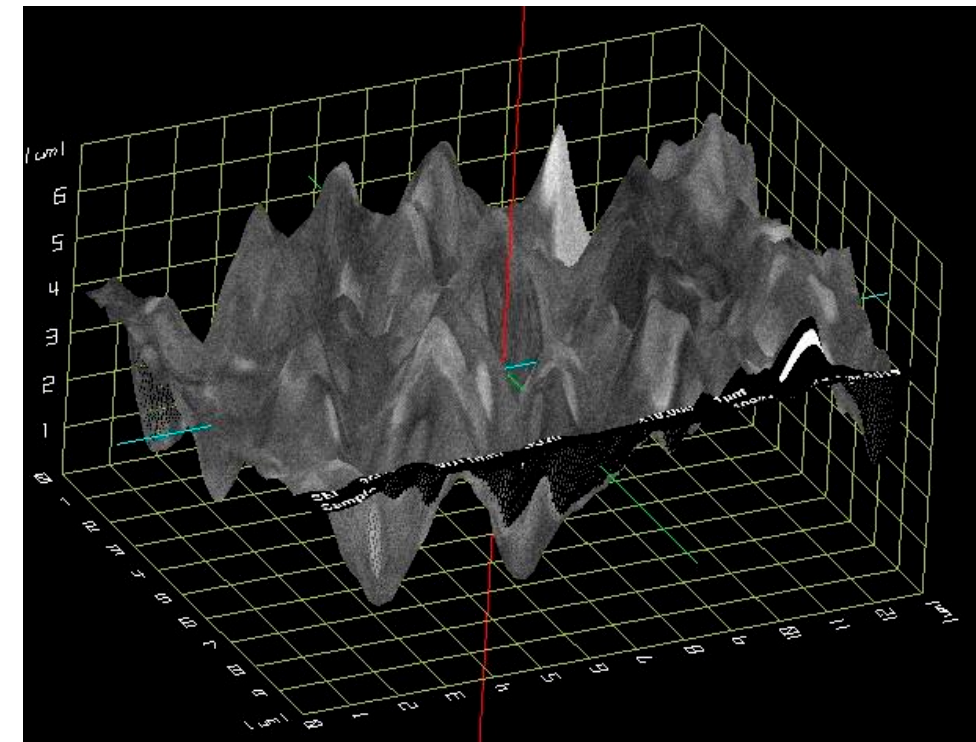
Figure 5. Surface relief of Fe-Cr-Al alloy foil after heating at 900 °C for 10 h.